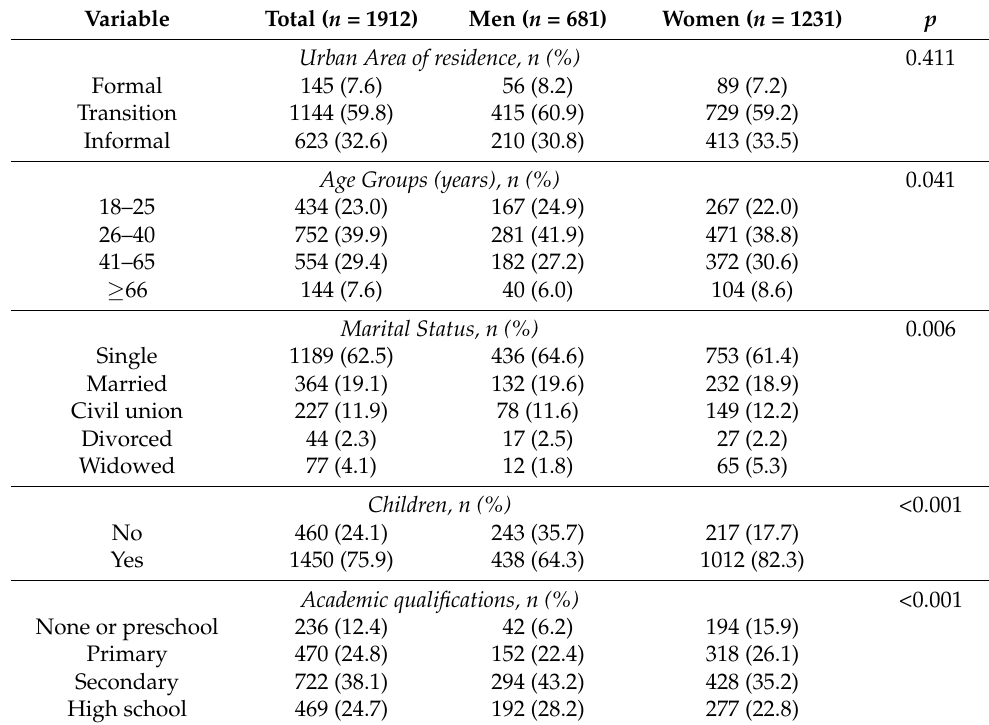
Table 1. Urban area of residence, sociodemographic characteristics, and alcohol consumption of participants by